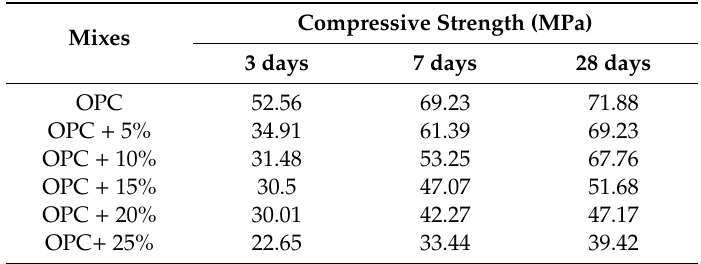
Table 3. Compressive strength of the ordinary Portland cement (OPC) blended cement pastes containing di ff erent ratios of calcined CMW for 3, 7, and 28 days. Mixes